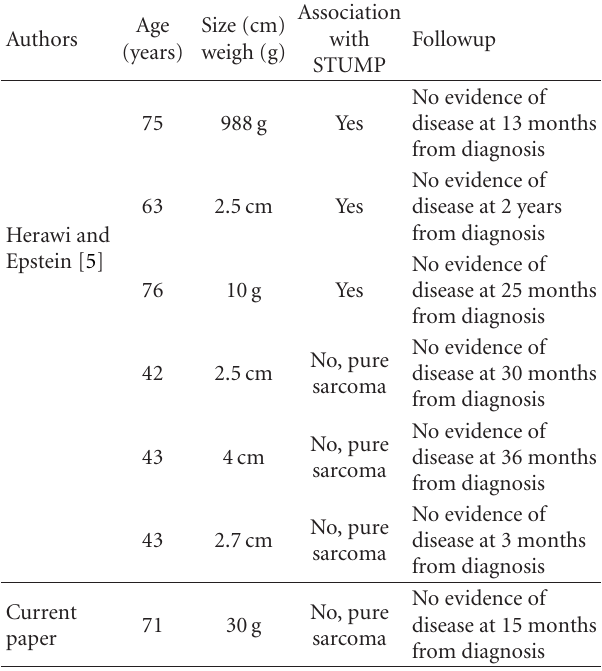
Table 1: Review of The literature of low-grade prostatic